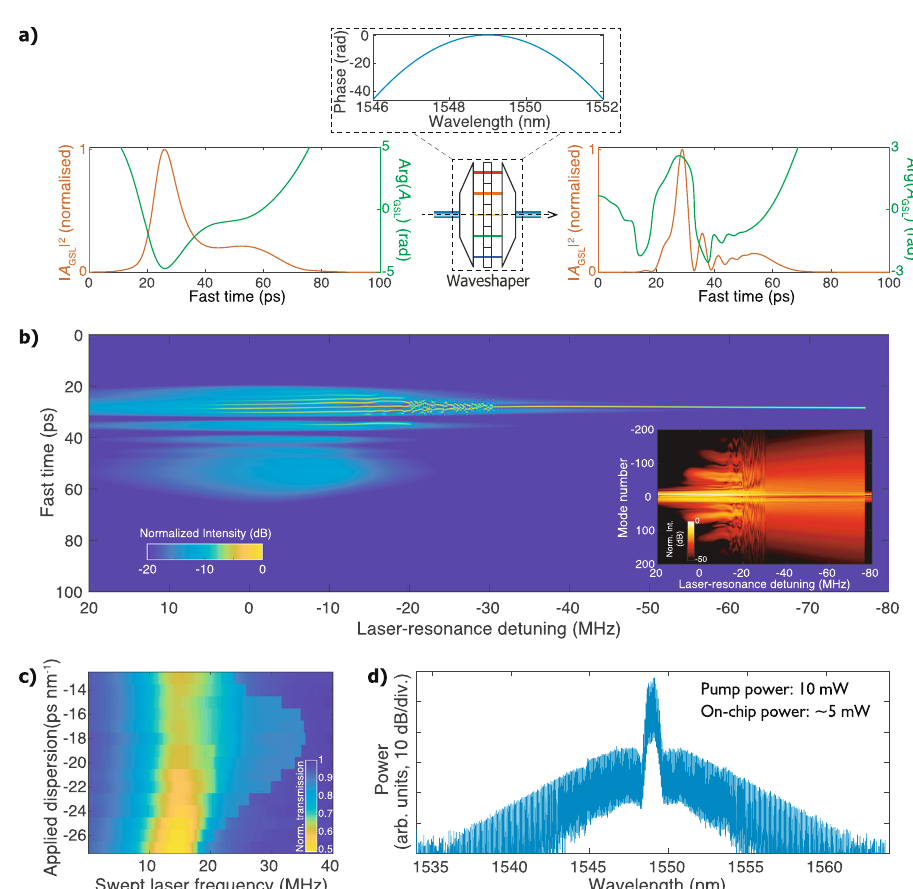
Fig. 5 Importance of phase engineering in pulse pumping with a gain-switched discrete mode laser. a Auxiliary dispersion is applied to the simulated GSL pulse in order to achieve a phase maximum around the intensity peak. b Simulated soliton generation with externally chirped GSL pulses. The comb spectrum evolution is displayed in the inset. c Contour plot of the laser-frequency-swept transmission using the DM GSL with varied applied dispersion. d Single-soliton microcomb spectrum experimentally generated with 10 mW of the DM GSL power using an external dispersion of − 18 ps nm − 1